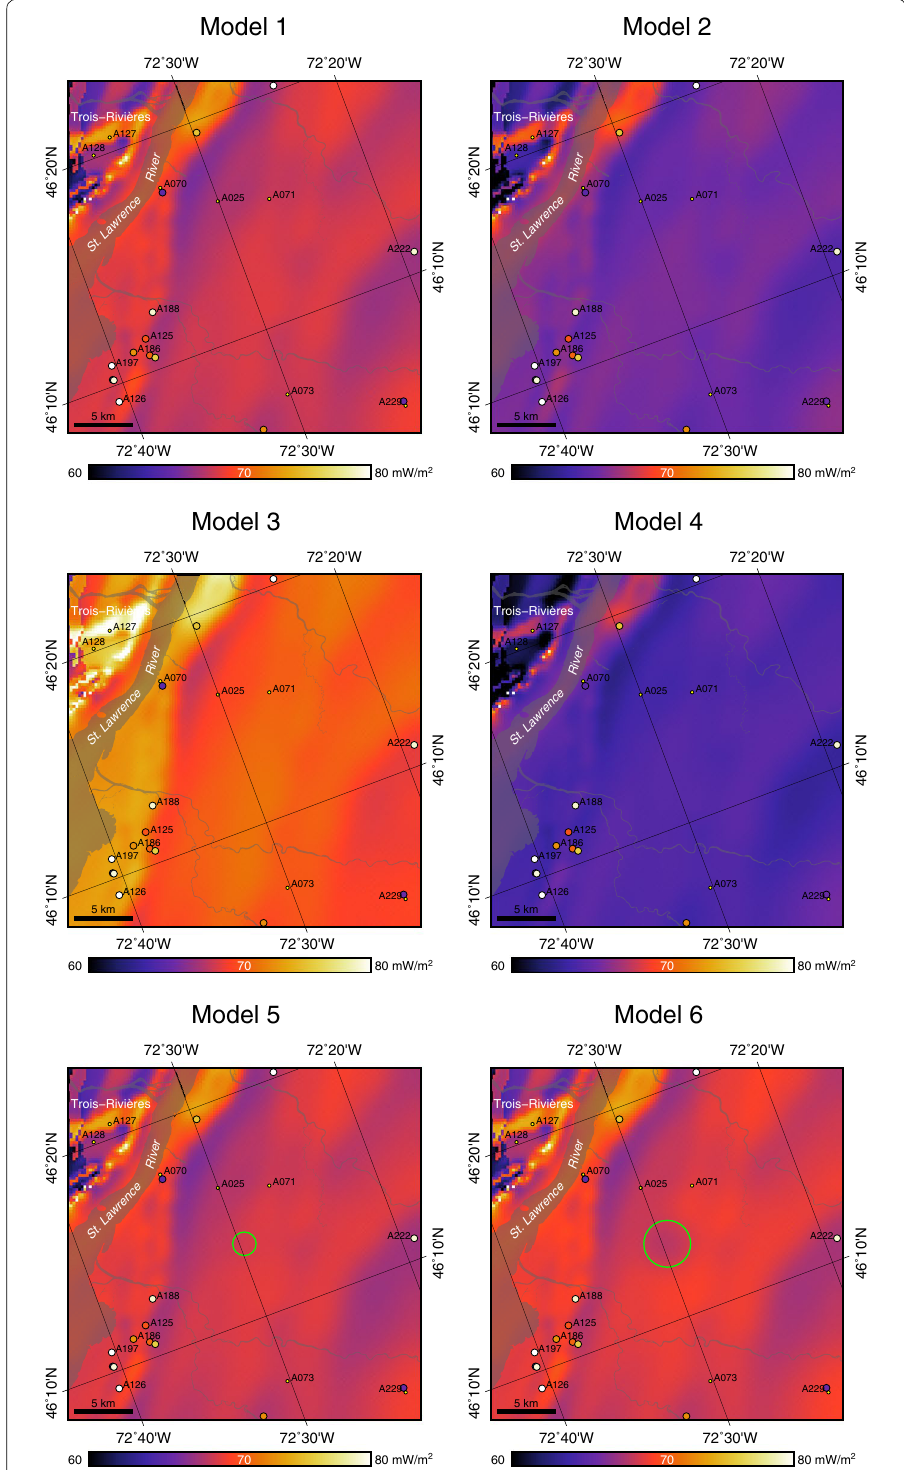
Fig. 14 Surface heat flow modeled for the six scenarios. Small circles are data points from Bédard et al.